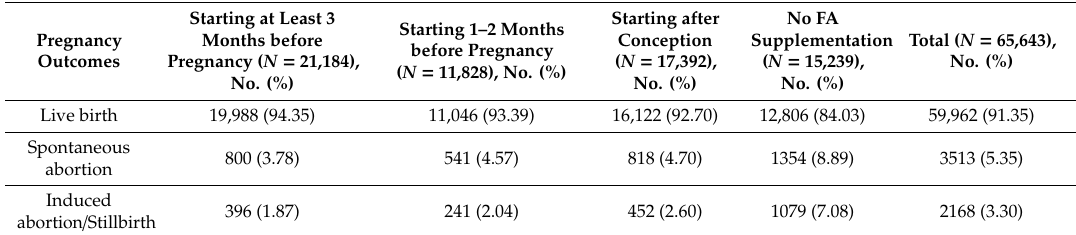
Table 1. Pregnancy outcomes according to maternal periconceptional folic acid (FA)